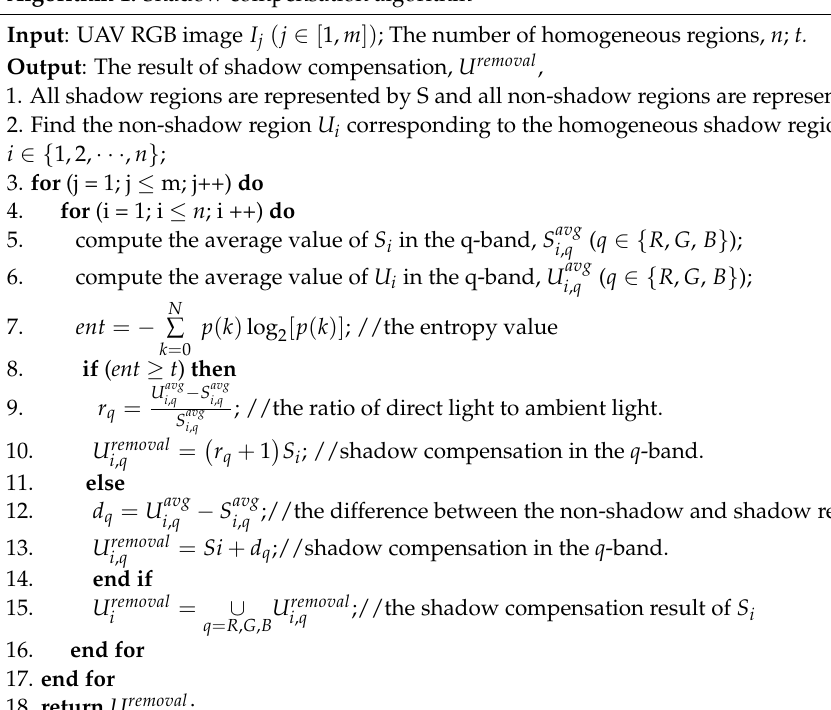
Algorithm 1. Shadow compensation algorithm